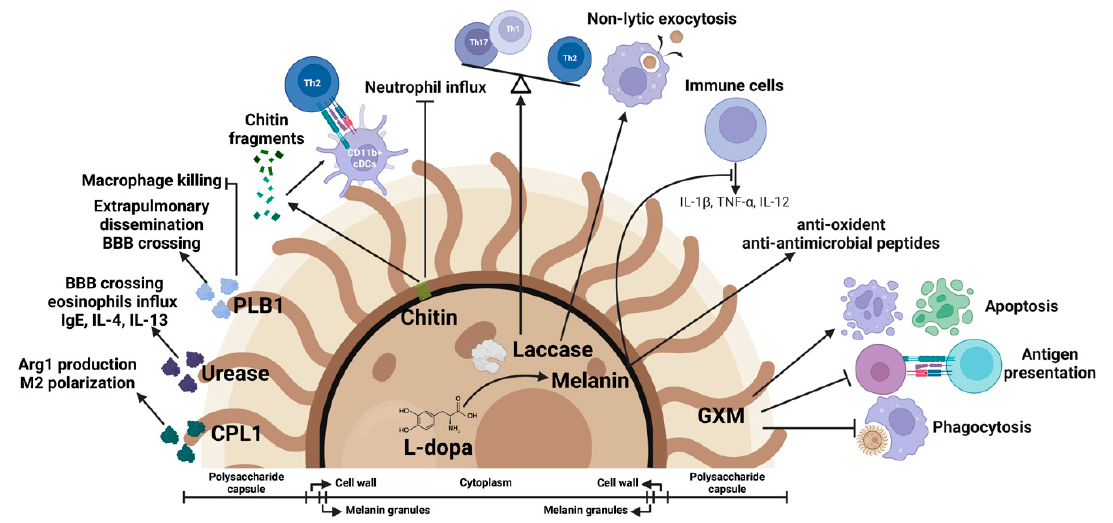
Figure 3. Cryptococcal virulence factors as immune modulators. Fungal virulence factors mediate cryptococcal pathogenesis and function as host immune modulators. Glucuronoxylomannan (GXM) from the polysaccharide capsule inhibits phagocytosis of C. neoformans by macrophages, suppresses antigen presentation, and induces apoptosis of macrophages and T cells. Melanin protects the yeast cells from oxidants and antimicrobial peptides. Melanization suppresses the production of cytokines such as IL-1 β , TNF- α , and IL-12. Laccase, an enzyme required for biosynthesis of melanin, is involved in regulation of nonlytic exocytosis of C. neoformans from macrophages and contributes to the skewing of Th1/Th17 to Th2 immune responses. Chitin fragments promote Th2 responses and inhibit neutrophil influx. PLB1 promotes fungal dissemination and inhibits macrophage killing. Urease facilitates fungal brain invasion and induces Th2 responses. Secreted protein CPL1 promotes arginase-1 production and shapes the M2 polarization.